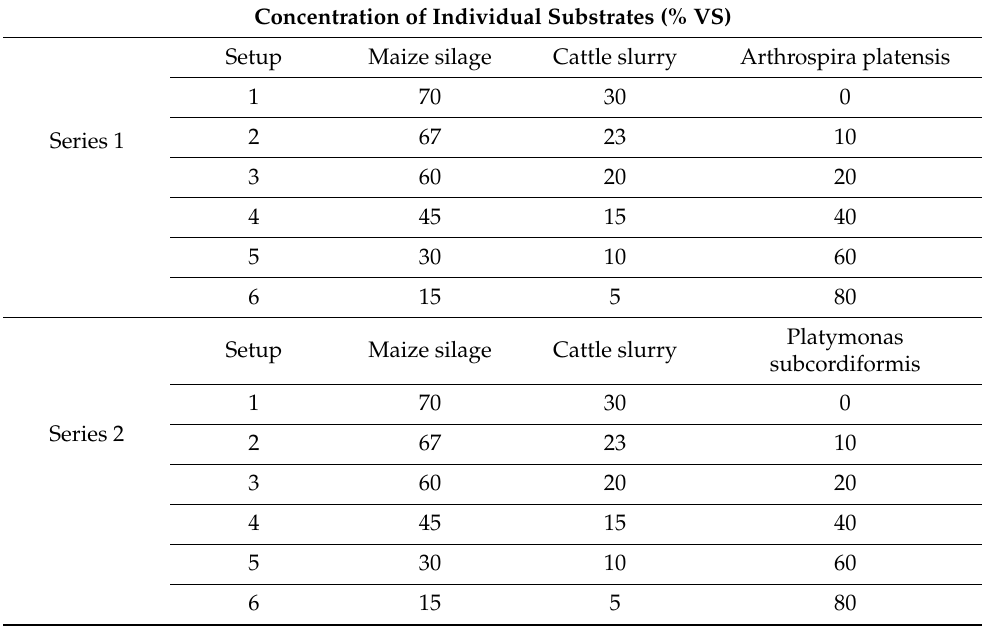
Table 2. Experimental setup. VS: volatile